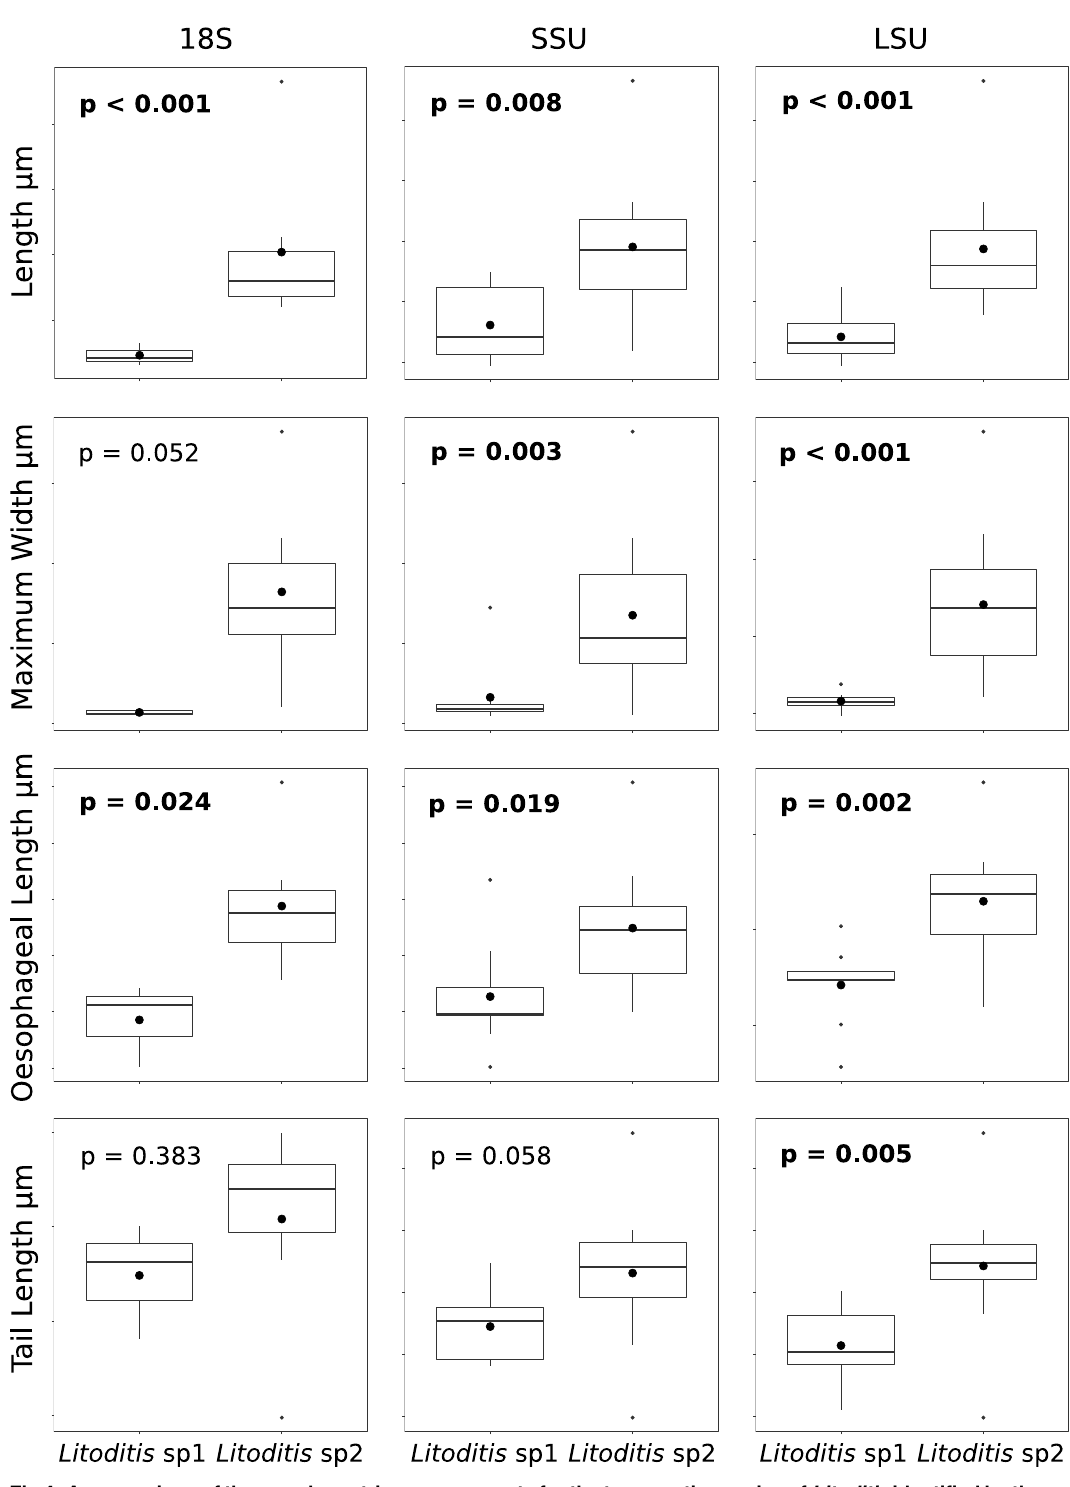
Fig 4. A comparison of the morphometric measurements for the two cryptic species of Litoditis identified by the molecular analyses. The p values correspondto the results of one-wayANOVA.